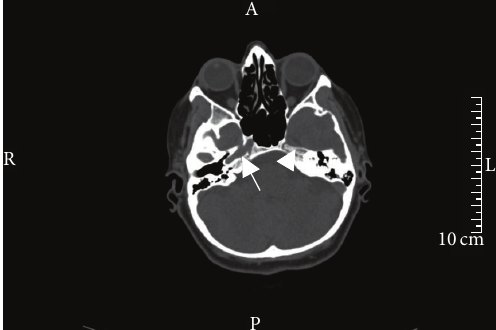
Figure 2: This axial CT image of the cranial base shows that while the carotid canal in the petrosal bone is clearly visible on the right side (arrow), there is no visibility of a left carotid canal (arrow